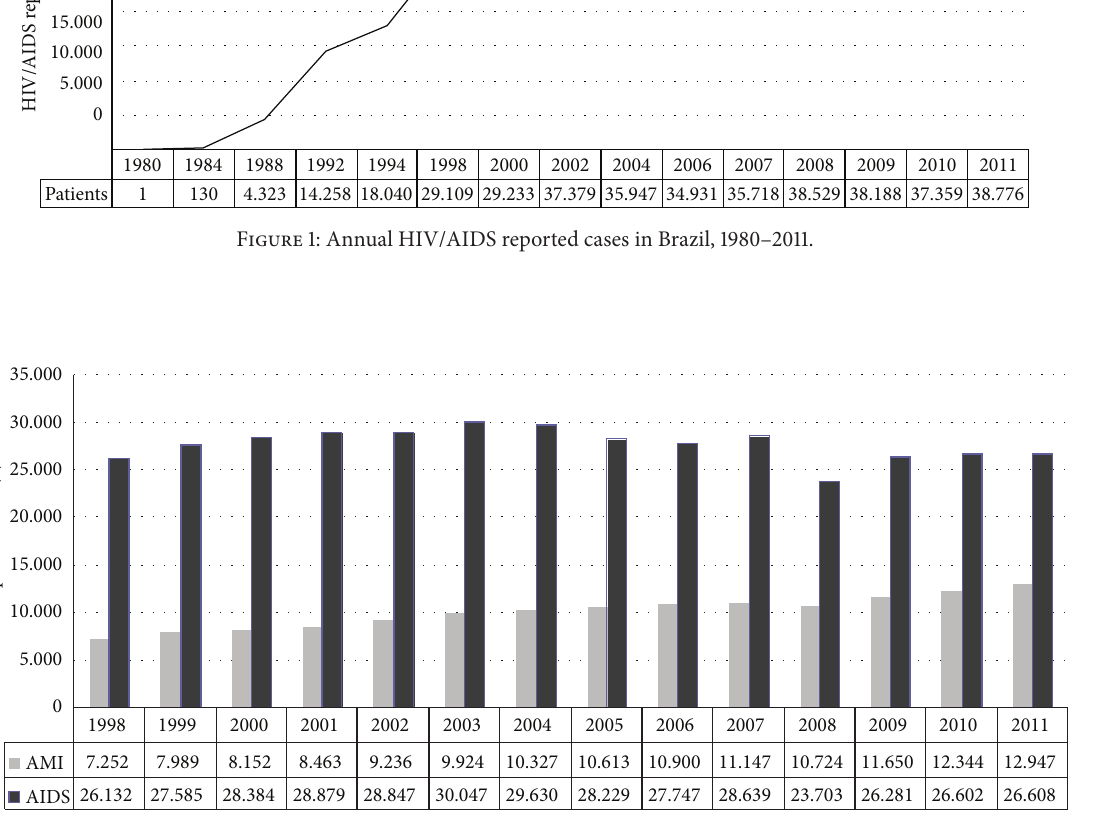
Figure 2: Annual hospitalizations due to AMI and AIDS (25–49 years).